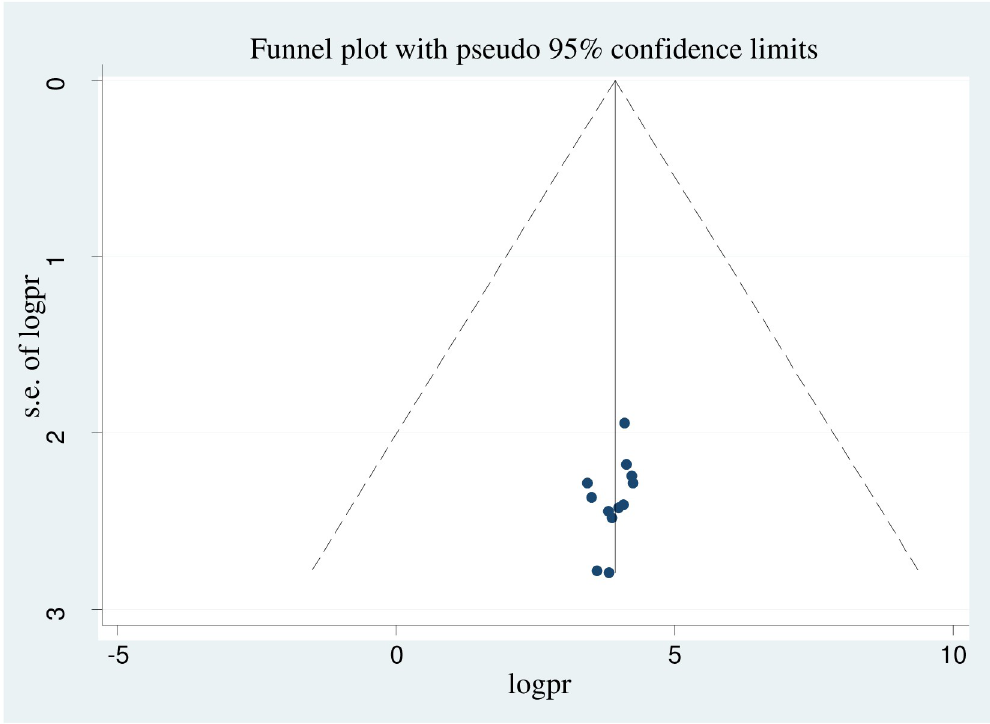
Fig 3. Funnel plot showing symmetric distribution of articles on COVID-19 vaccine acceptance in Ethiopia,